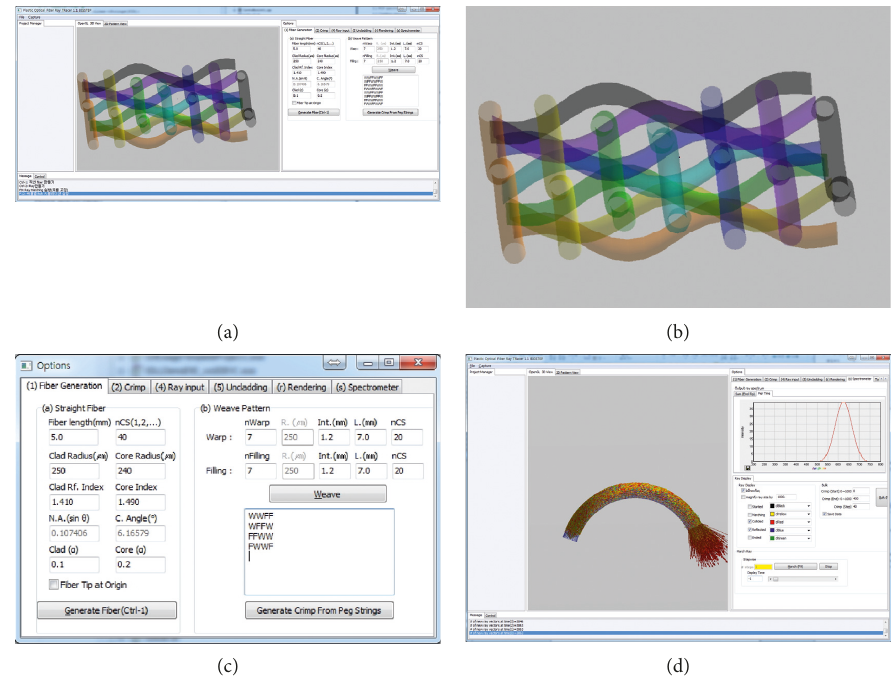
Figure 4: Fabric weave structure modeling result. (a) Program screenshot; (b) rendered view of 2 by 2 twill structure in detail; (c) fabric dimension and structure input window in detail; (d) theoretical light scattering measurement.